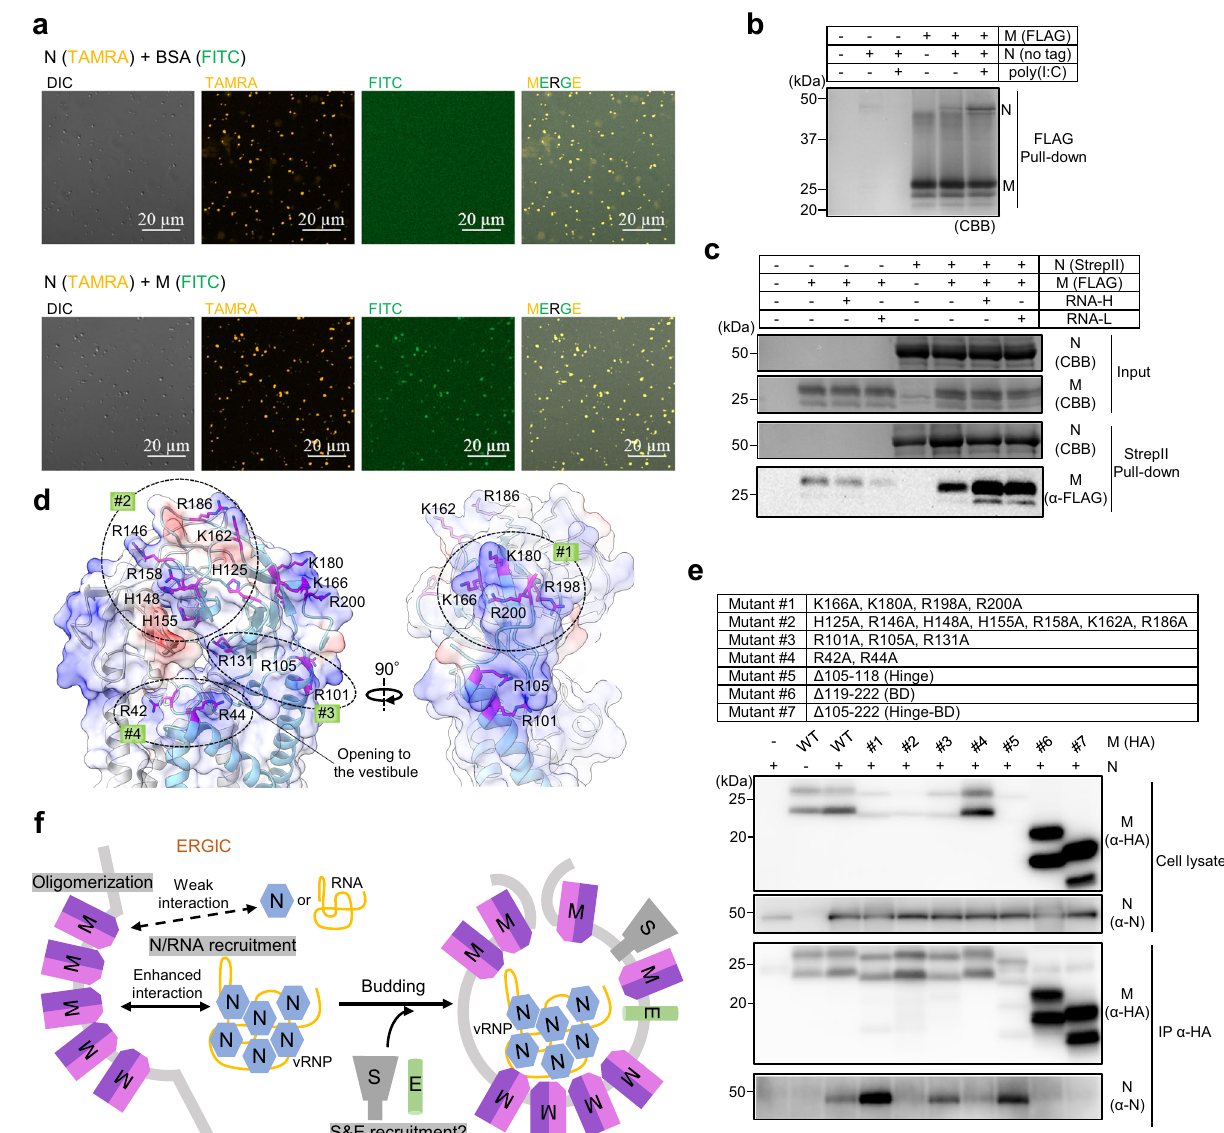
Fig. 4 | M protein, N protein, and RNA interactions. a Differential interference contrast (DIC) and fl uorescence images of liquid-liquid phase separation (LLPS) of N protein (TAMRA-labeled) with or without M protein (FITC-labeled). The experi- ment was repeated three times with similar results. b FLAG tag pull-down assay using recombinant M protein (FLAG-tagged) and N protein (no tag) in the absence or presence of poly(I:C). The experiment was repeated twice with similar results. Source data are provided as a Source Data fi le. c StrepII tag pull-down assay using recombinant N protein (StrepII-tagged) and M protein (FLAG-tagged) in the absence or presence of RNAs of different sizes. RNA-H and RNA-L indicate yeast RNA with molecular weights >30kDa and 3 – 30kDa, respectively. The experiment was repeated twice with similar results. d Electrostatic surface potentials of the